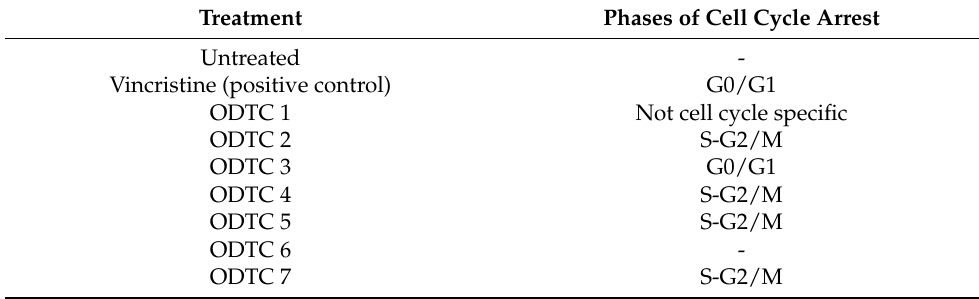
Table 2. Summary of organotin(IV) dithiocarbamate action on the cell cycle